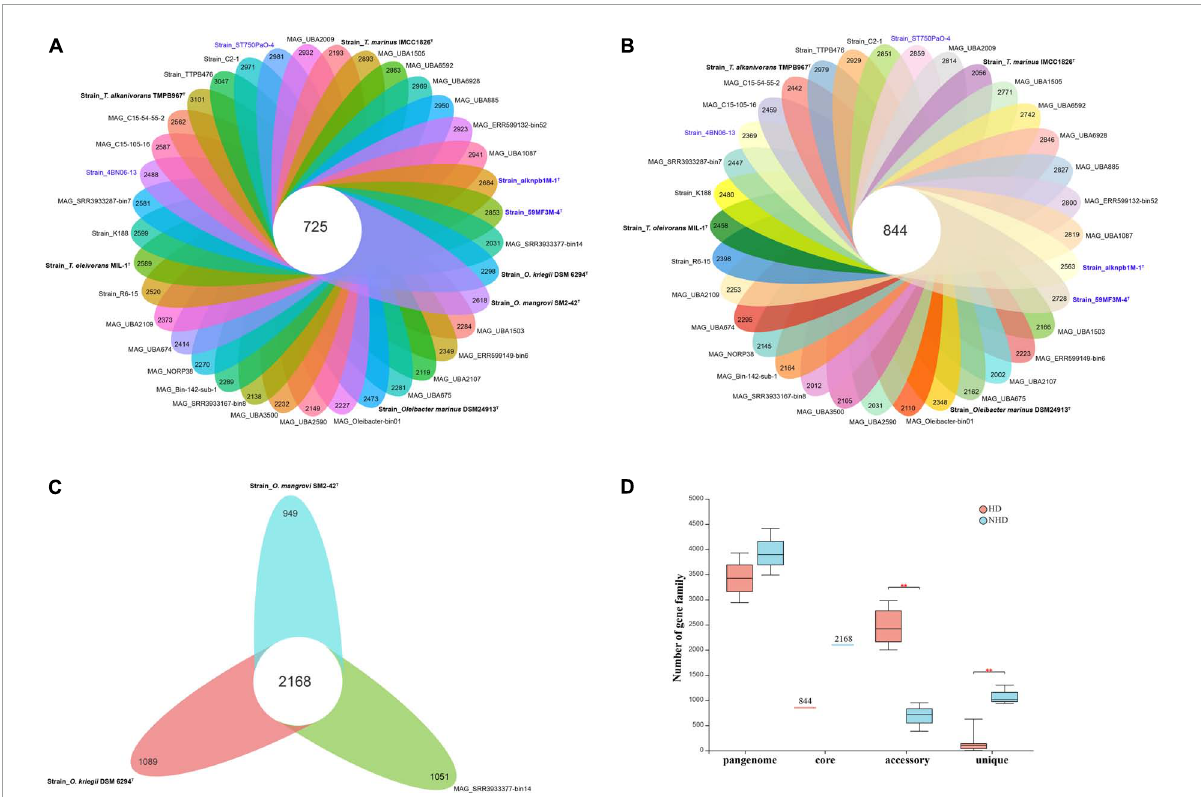
FIGURE5 The pangenomes of Oceanobacter -related bacteria (ORB) strains. (A) Flower plots showing the core gene number (in the center) and the accessory gene numbers (in the petals) in the 37 strains. (B) Flower plots showing the core gene number (in the center) and accessory gene number (in the petals) in the hydrocarbon-degrading (HD) group. (C) Flower plots showing the core gene number (in the center) and accessory gene number (in the petals) in the non-hydrocarbon-degrading NHD group. (D) Variations in the numbers of pangenome, core, accessory, and unique genes between the HD and NHD groups. Significant levels in variations were determined using the Wilcoxon test (** P < 0.01) except for the core